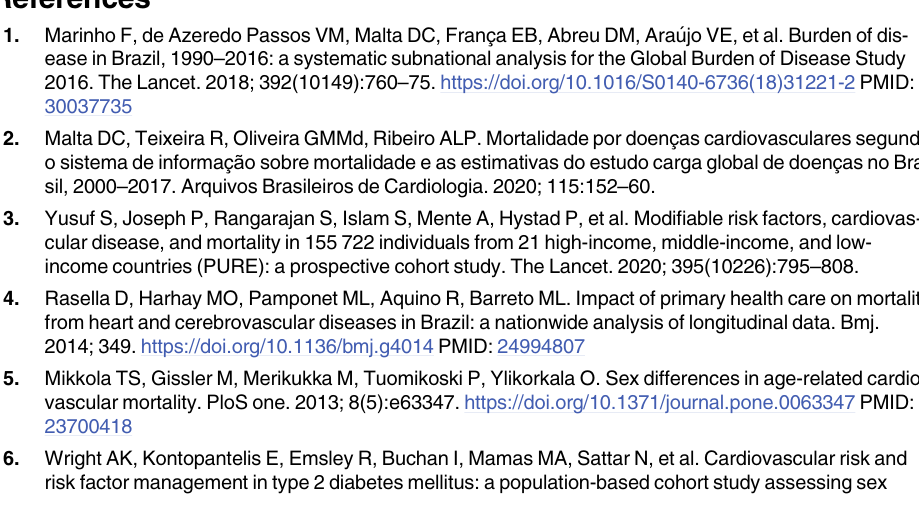
S5 Fig. Associations between SEV for risk factors and mortality due to cardiovascular dis- eases (CVD) in independent models. Risk factors were regressed with CVD mortality in dif- ferent, independent models. The unadjusted model (A) consisted of state and year fixed- effects and SEV of risk factors. The adjusted model included: doctors per 1,000 habitants, hos- pital beds per 1,000 habitants, coverage of primary care, Bolsa Famı´lia transfer, GDP per cap- ita, state and year fixed effects and SEV of risk factors. Mortality and SEV were per 100,000 people. Estimates and 95% confidence intervals (CI) are provided in the figure. SBP: systolic blood pressure. LDL: low-density lipoprotein. BMI: body mass